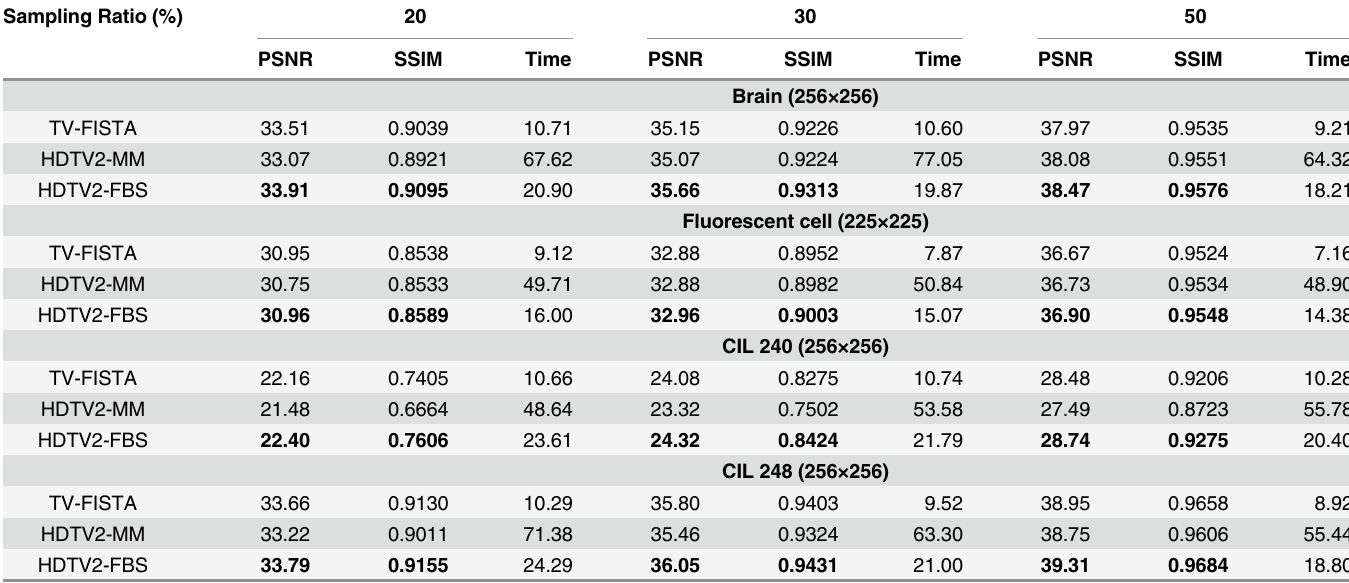
Table 2. PSNR (dB), SSIM and running time (s) results of different methods on test